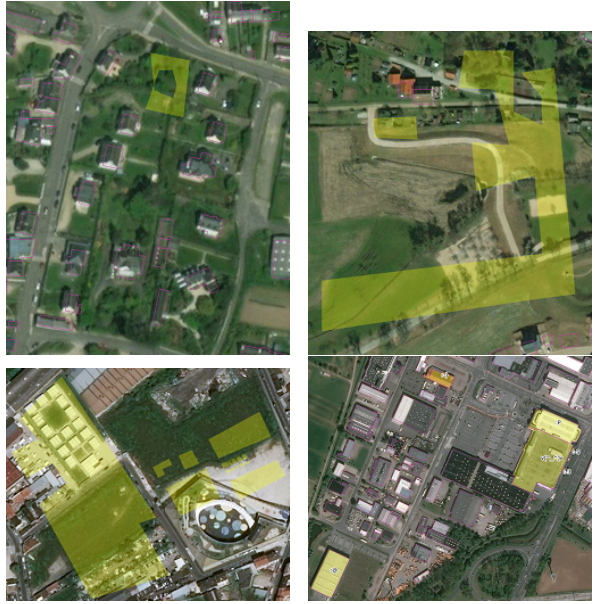
Figure 5. Fake vandalism examples. Table 1. Count of vandalized buildings and OSM buildings in each study